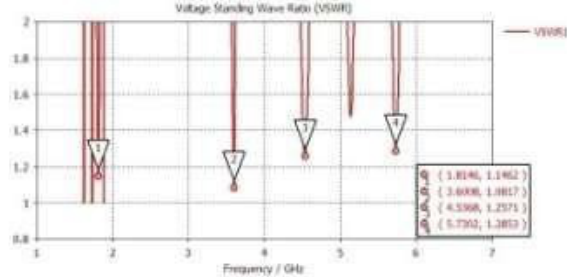
Figure 3.VSWR plot of the simulated antenna .